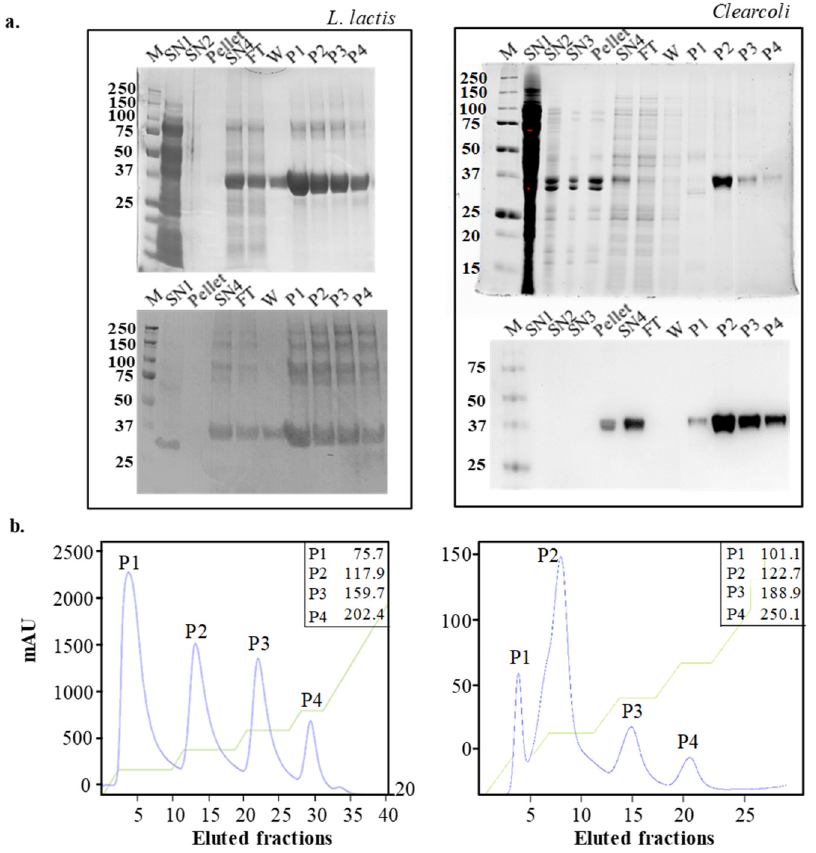
Figure 1. Detection of protein bands from inclusion bodies (IBs) produced in L. lactis (left) and Clearcoli (right) obtained during solubilization procedure. For each expression system, SDS–PAGE (above) and Western blot analyses (below) are shown ( a ). Immobilized metal affinity chromatography (IMAC) chromatograms for purifications of solubilized MMP-9 samples produced by L. lactis (left) and Clearcoli (right). Blue lines depict the absorbance signal (mAU) along the elution process and green lines the elution buffer (EB) gradient progress. The corresponding concentration of imidazole (mmol/L) is indicated for each eluted peak in the inset ( b ). SN1: soluble cell fraction of the cell lysate; SN2: soluble protein content after the first wash of the insoluble cell fraction; SN3: soluble protein content after second wash; pellet: pellet after solubilization of IBs with N-lauroylsarcosine; SN4: proteins solubilized from IBs after N-lauroylsarcosine treatment; FT: Flow-through; W: wash; P1-P4: protein peaks. M: molecular weight marker in